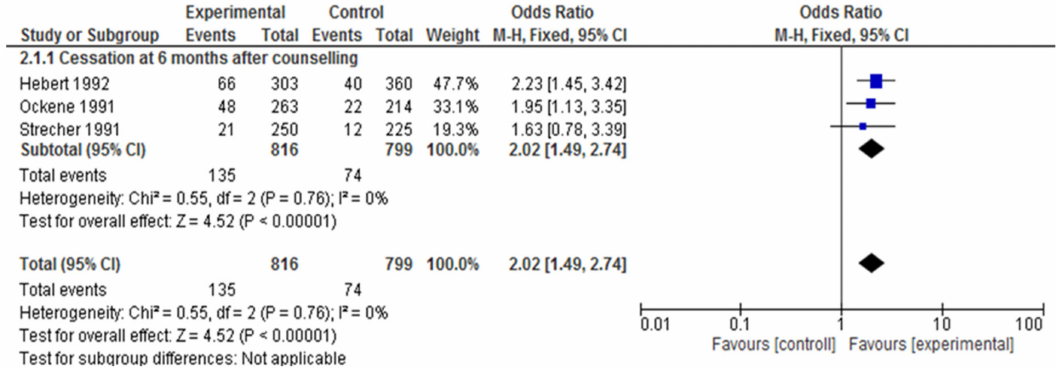
Figure 7. Forest plot for patient smoking cessation at six months after